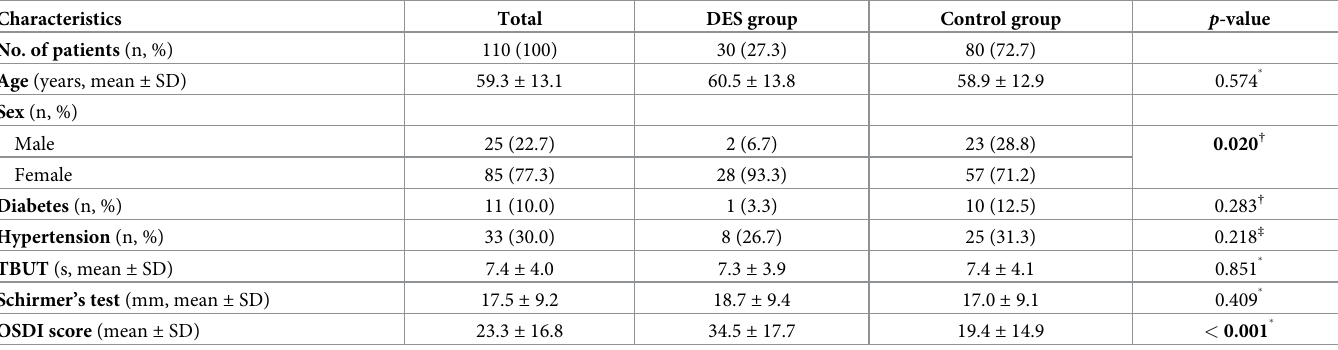
Table 1. Demographics and preoperative data in the DES and control groups.